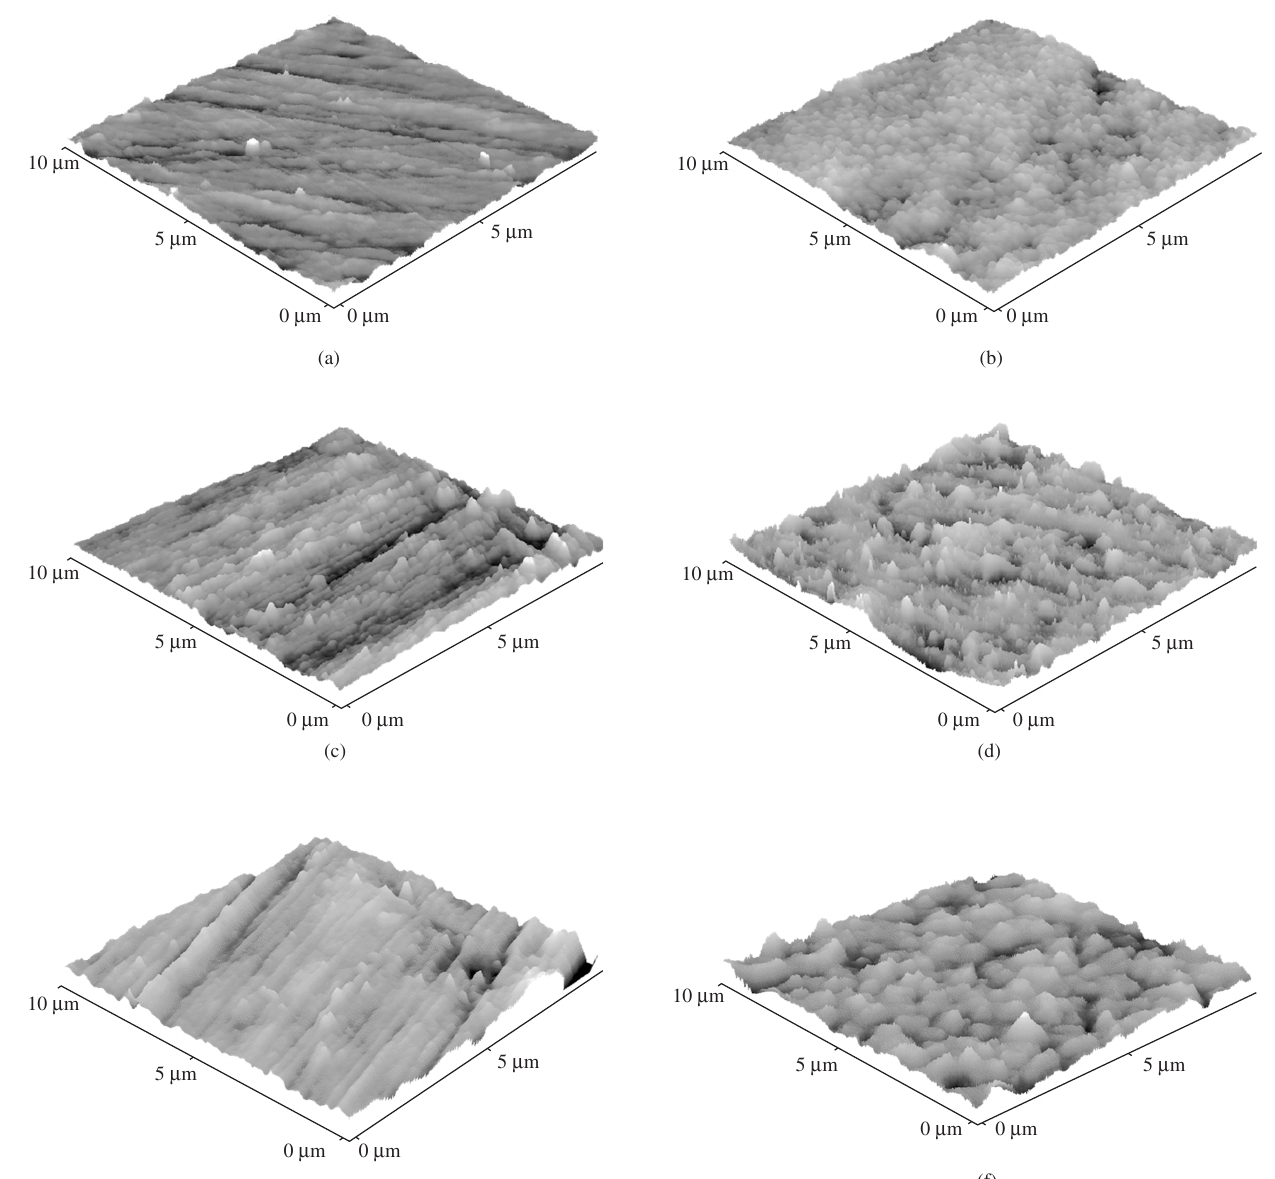
Figure 3. AFM images a) bare GC, b) GC/TFSF, c) bare Au, d) Au/TFSF e) bare Pt and f)